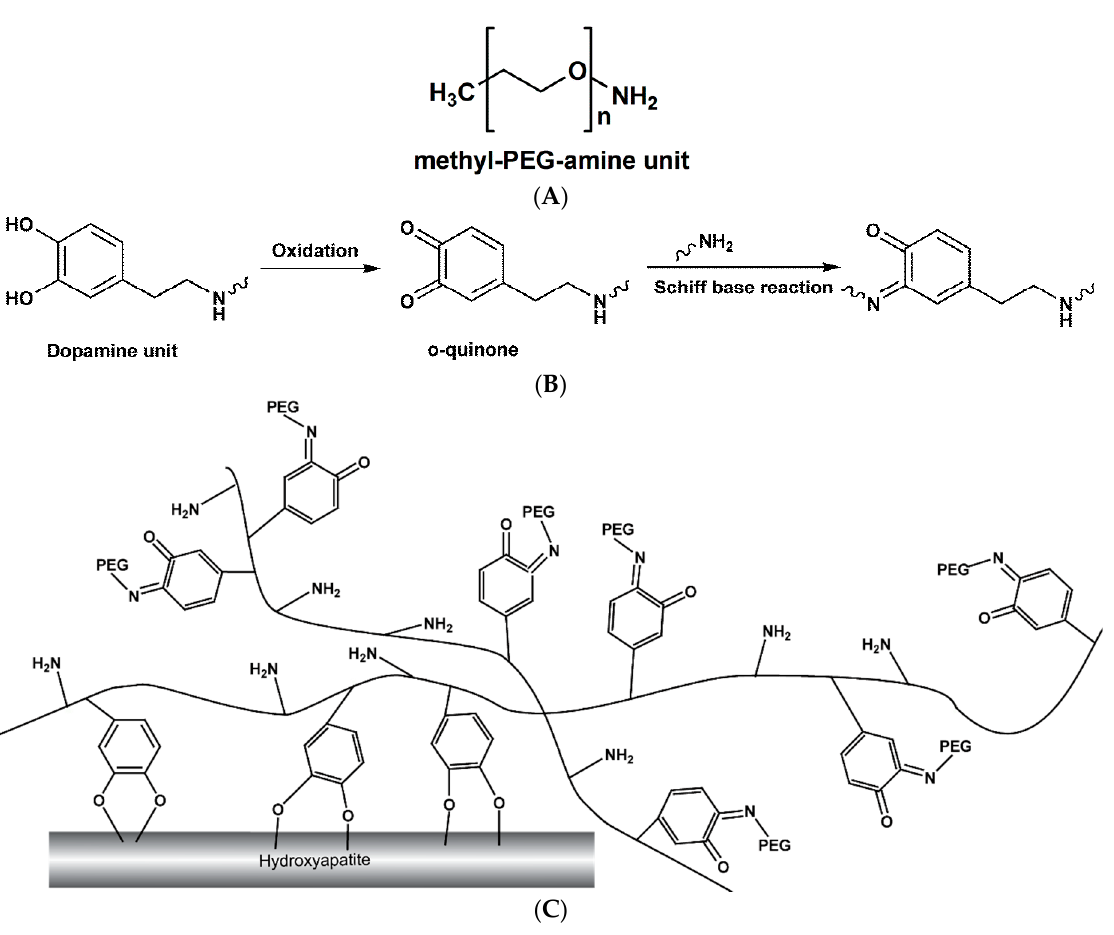
Figure 7. Schematic diagram illustrating interfacial location of aminated polyethylene glycol, polydopamine, and hydroxyapatite. ( A ) methyl-polyethylene glycol (PEG)-amine unit; ( B ) Immobilization of selenocystamine via polydopamine linker [38]; ( C ) Interfacial location of aminated PEG, polydopamine and hydroxyapatite [15].